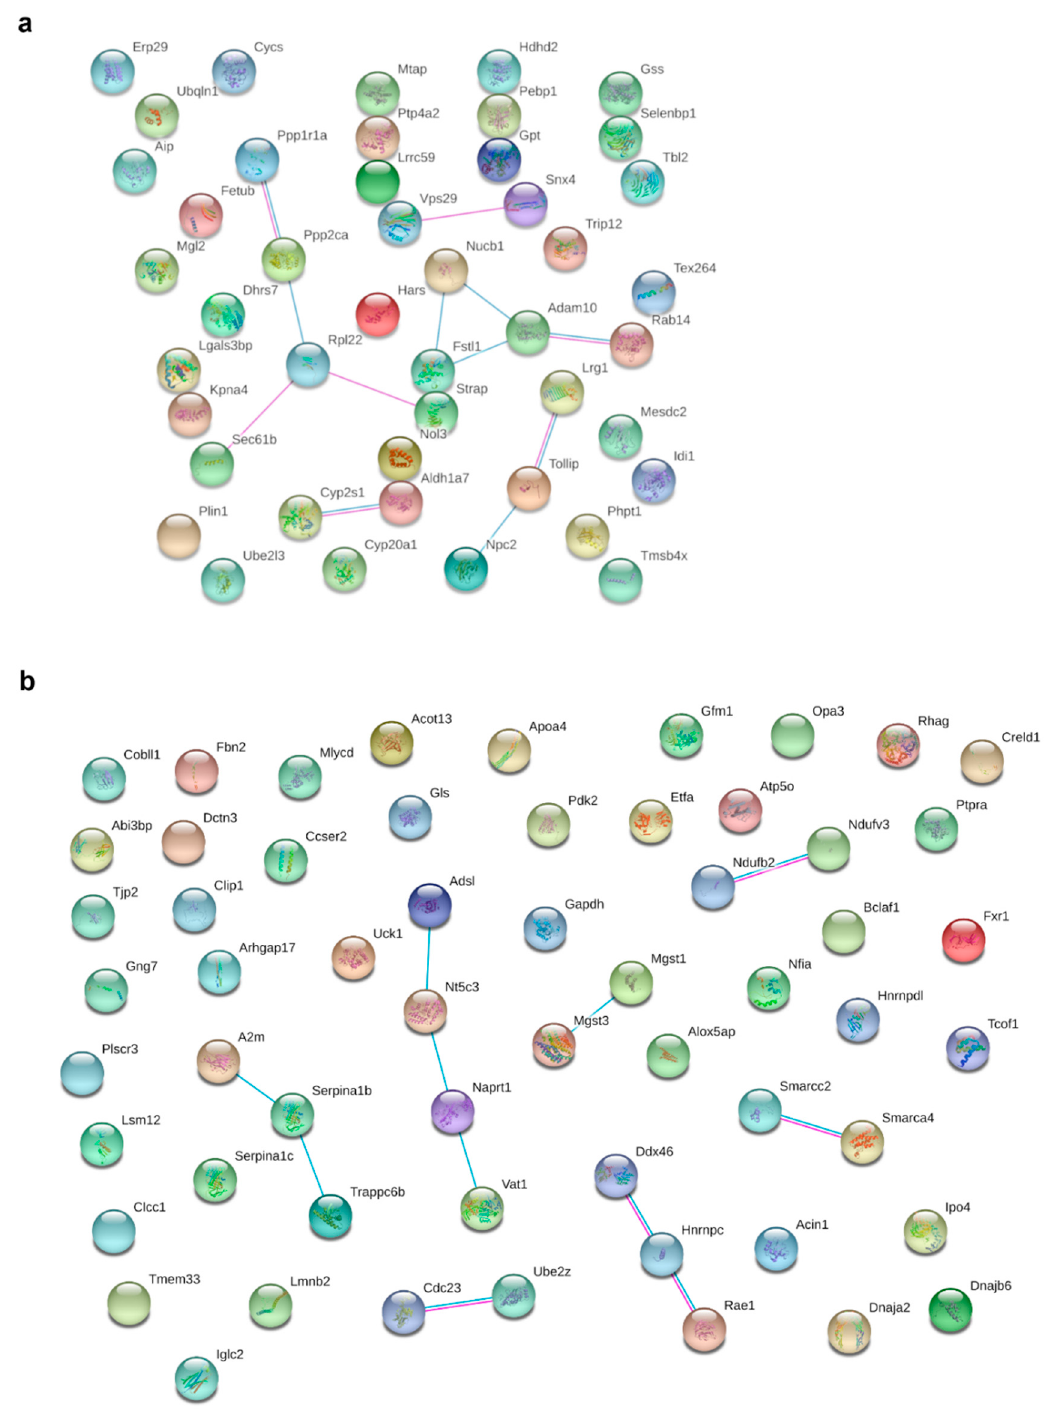
Figure 4. Potential interactions, indicated by lines between two proteins (blue: based on curated databases, pink: experimentally determined), were determined by STRING analysis between signif- icantly (fold change > 1.5, q-value < 0.05) and relevantly (full or 0 valid values per group) altered proteins in pgWAT proteome. ( a ) shows downregulated proteins and ( b ) shows upregulated proteins by HFD + MF feeding compared to HFD feeding. HFD: high-fat diet; HFD + MF: high-fat diet plus metformin treatment; pgWAT: perigonadal white adipose tissue.